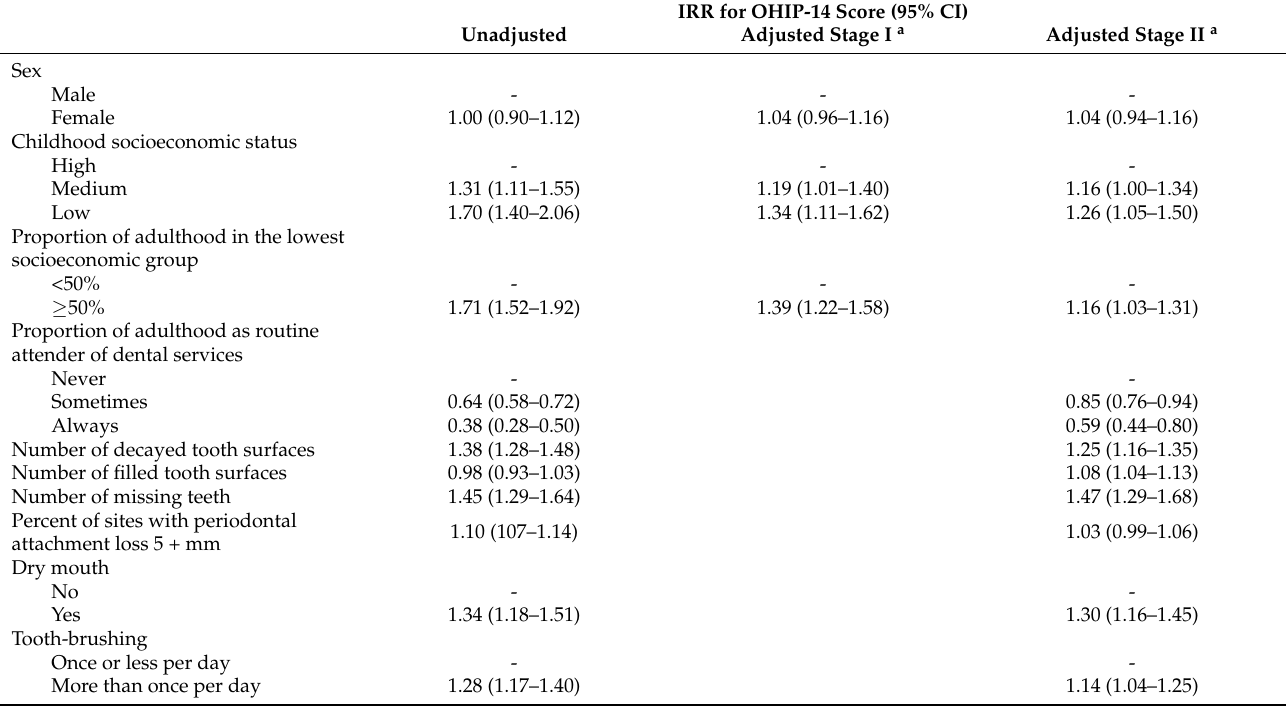
Table 4. Generalised estimating equation model for oral health impact profile (OHIP-14) scores from age 32 to 45